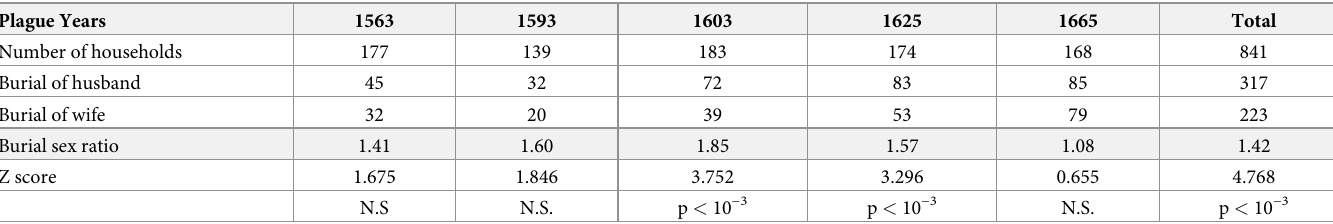
The sex ratios for each year, combined totals for the five years and the Z scores are also